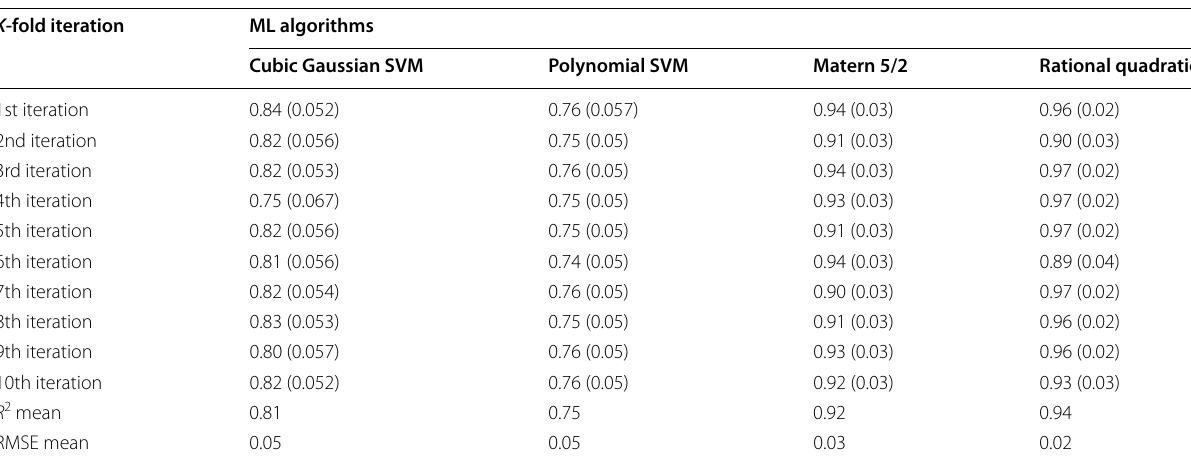
Table 5 R 2 of the K -fold cross-validation